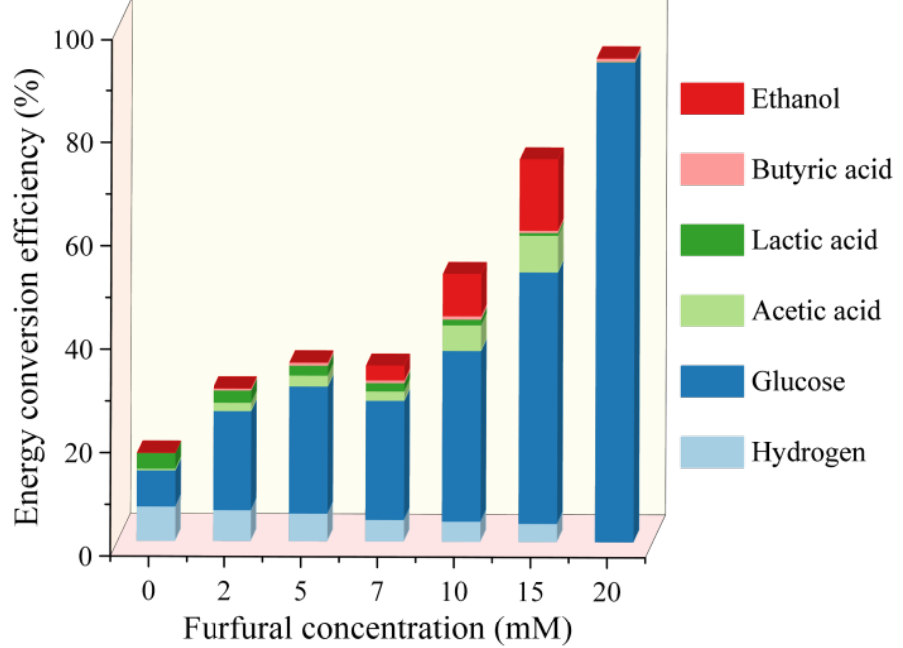
Figure 6. Energy conversion efficiencies (%) of photo-fermentation from glucose. The calculations were based on heating values of hydrogen (286 kJ/mol), glucose (2803 kJ/mol), butyric acid (2184 kJ/mol), acetic acid (874 kJ/mol), lactic acid (1235 kJ/mol), and ethanol (1367